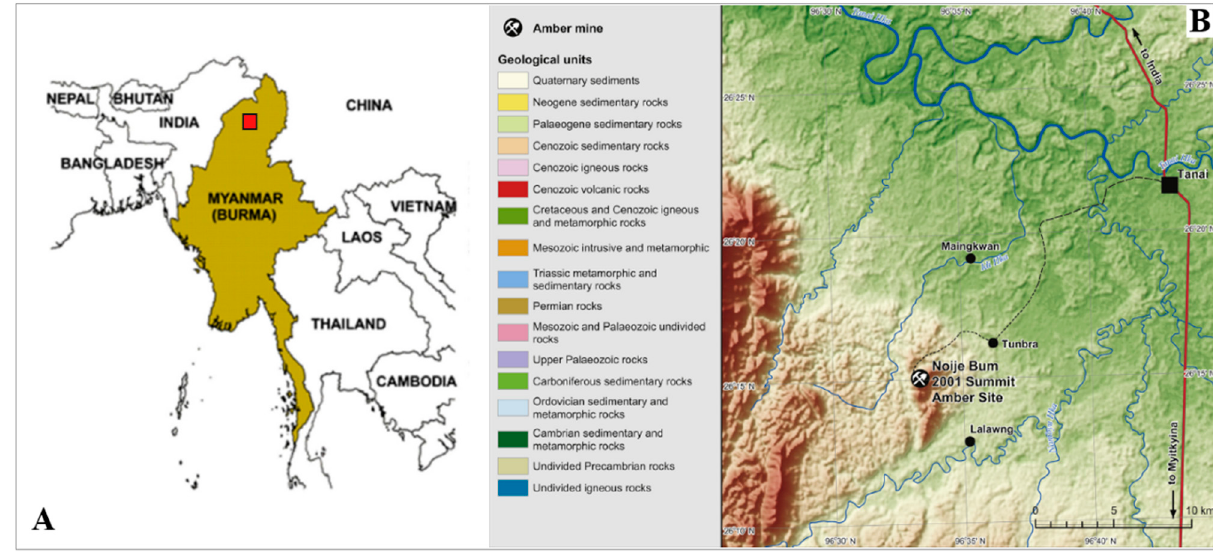
Figure 1. ( A ) Position of Myanmar. ( B ) Location of recent amber mining area in the Hukawng Valley, Myitkina Province, Myanmar. Compiled from data provided by known data [3,36,41–43], modified.